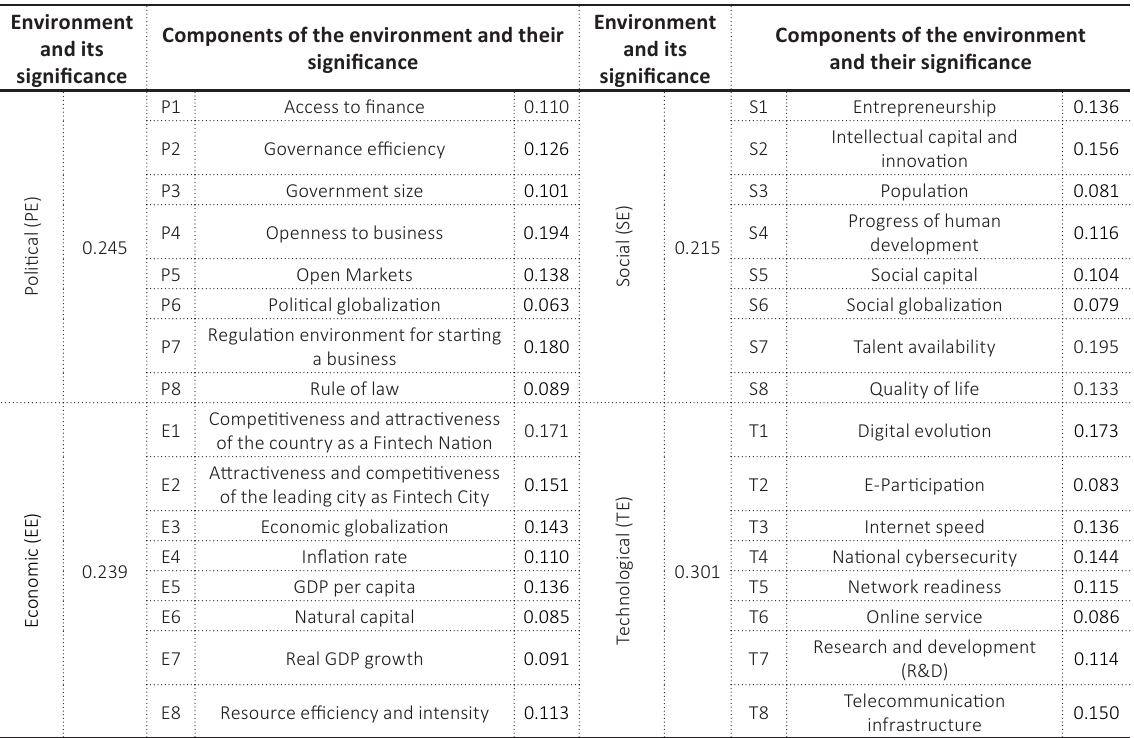
Table 1. Assessment tool for FinTech sector environment based on the PEST analysis of FinTech sector external environmental